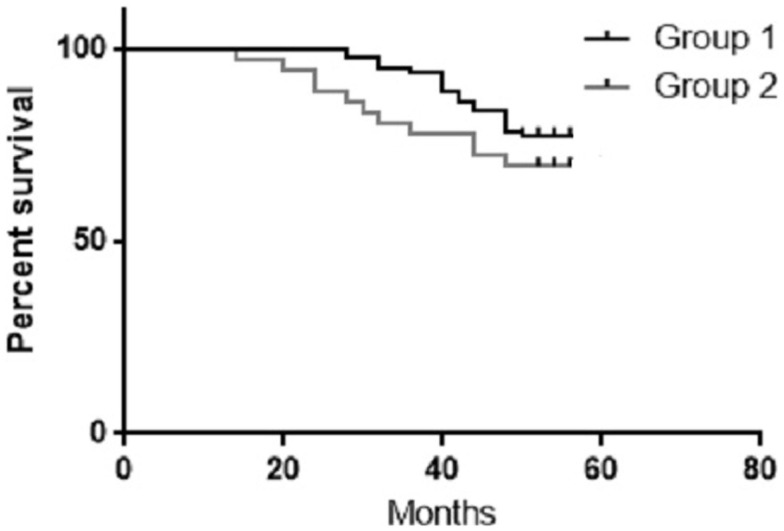
The 4-year OS for the study groups – p-value: 0.2, chi square 1.29.